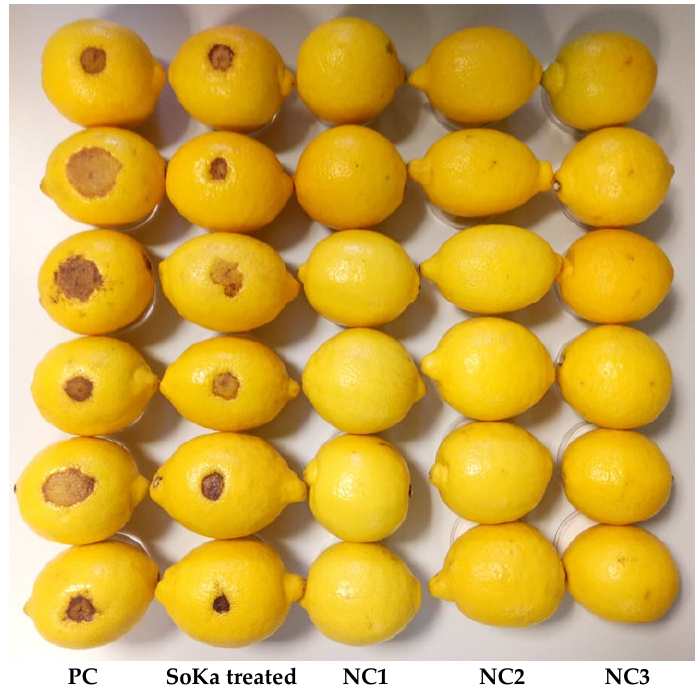
Figure A2. Lemon bioassay to test the efficacy of phage treatment on symptom reduction. Lemons were sterilized, treated with or without phage, and inoculated with the strain KB49. Tests were